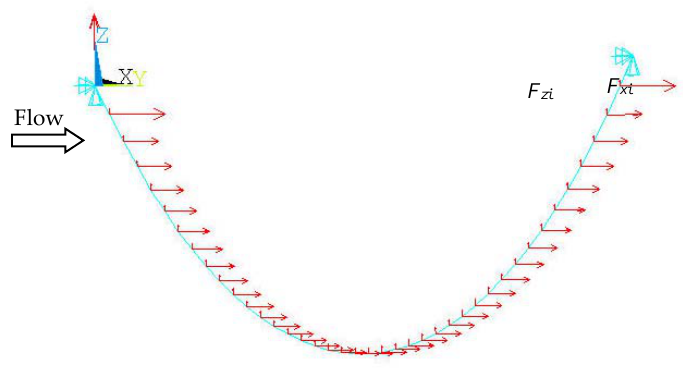
Figure 17. FE model of the jumper cable. Table 1. Calculating parameters of the jumper cable.